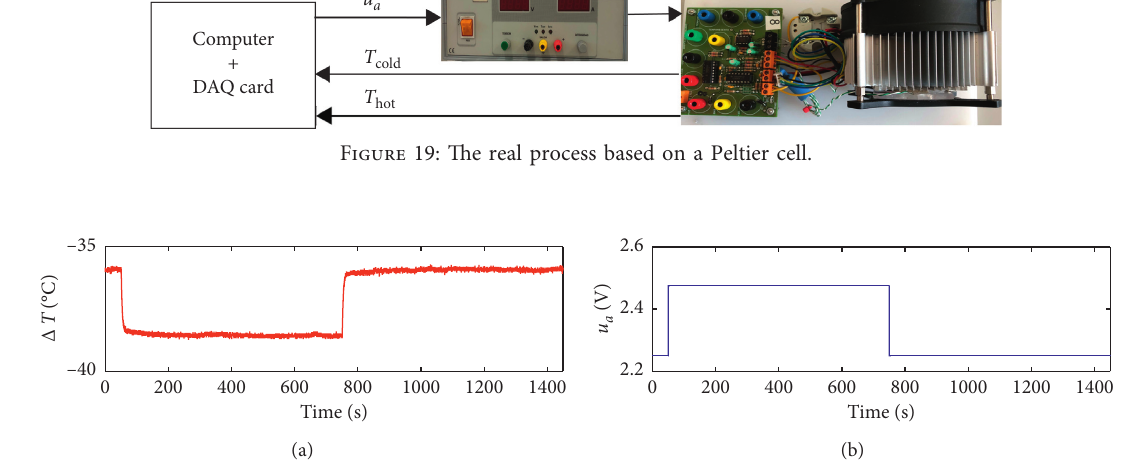
Figure 20: Input and output data for estimation of initial linear model (thermal process). (a) Excitation signal (blue). (b) Output signal of the thermal process (red).